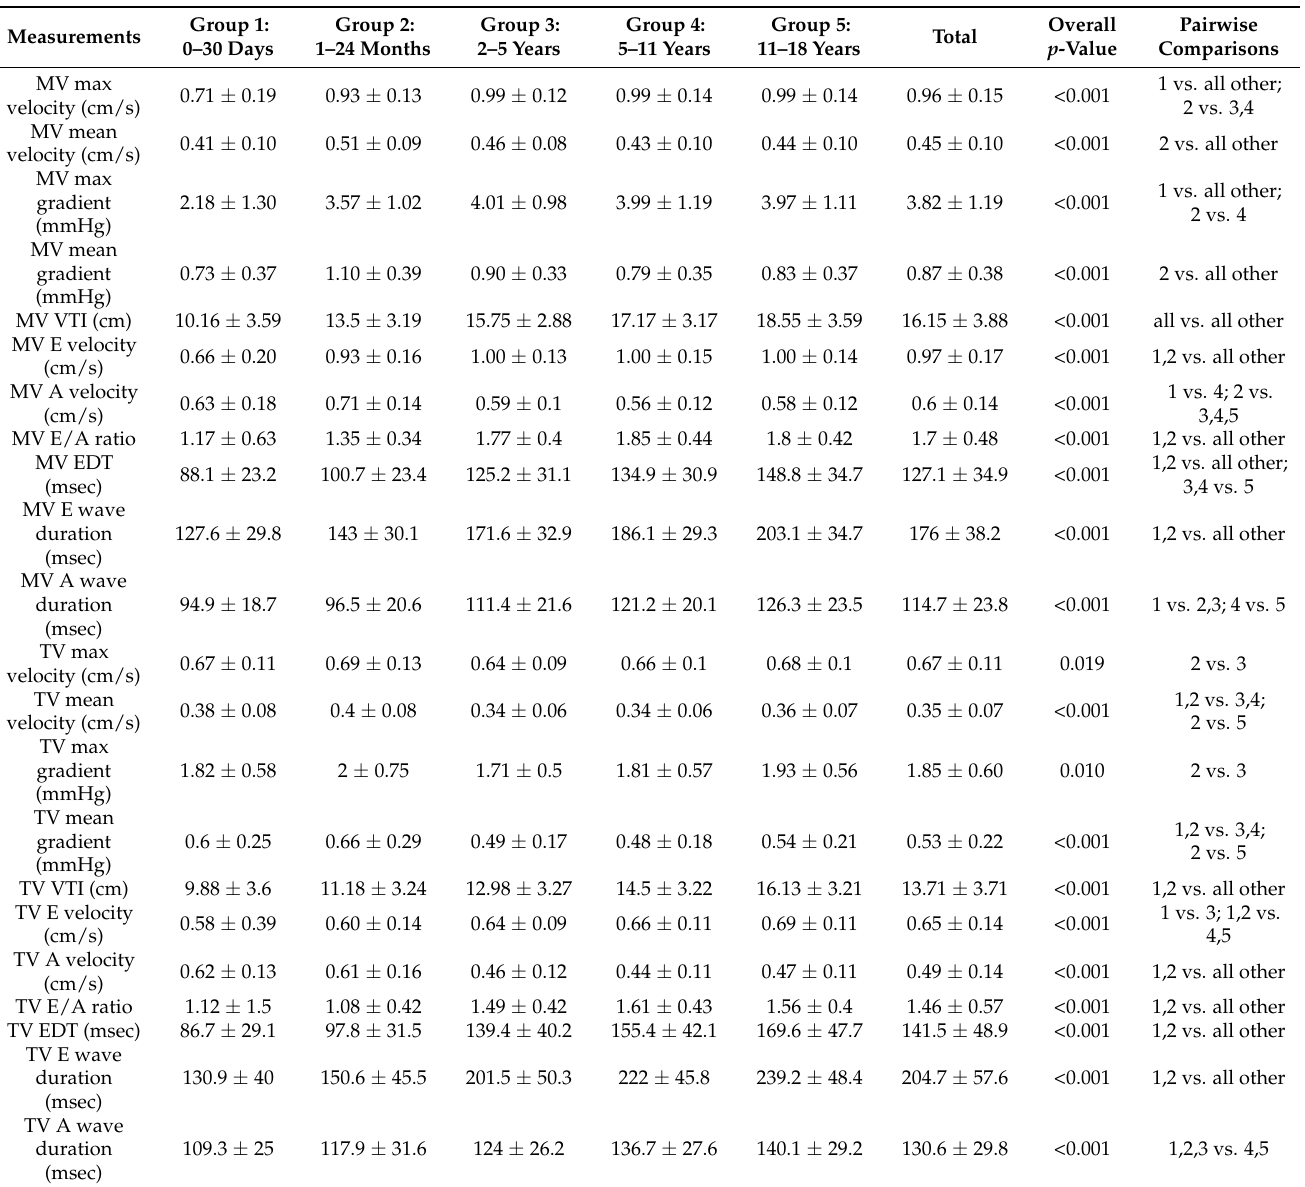
Table 2. Mitral (MV) and tricuspid valve (TV) Doppler values in healthy subjects: population means and standard deviation of the measurements by age groups. EDT, E wave deceleration time; VTI, velocity time